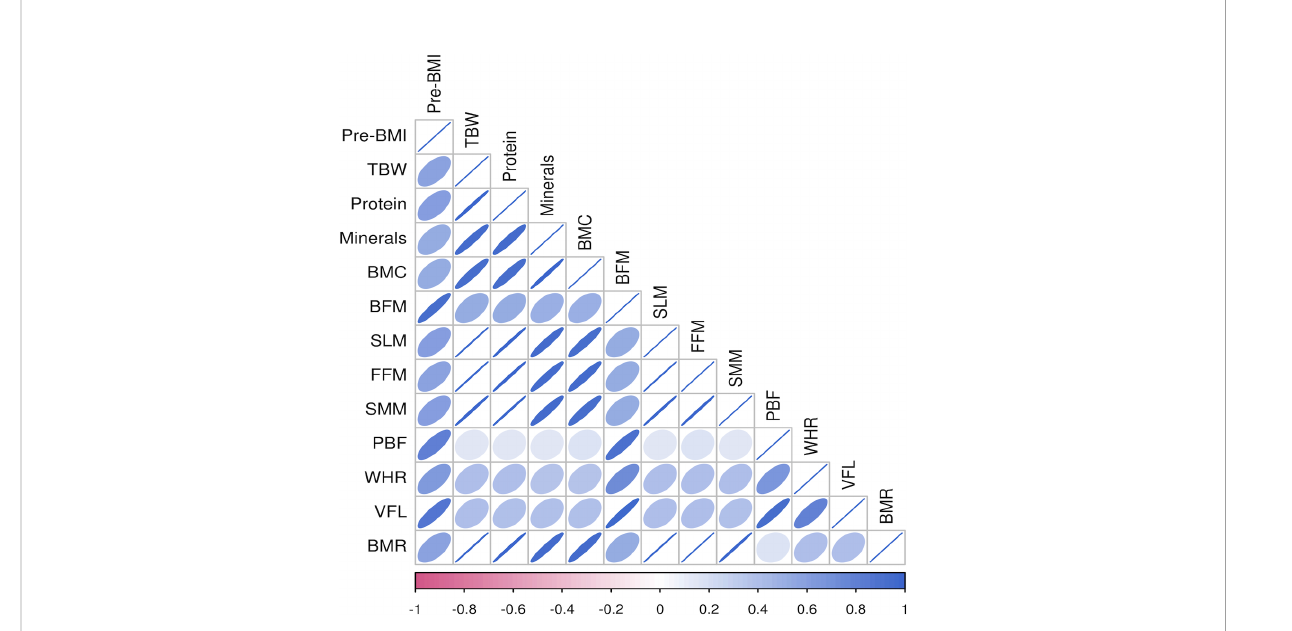
FIGURE 2 Heatmap of body composition correlations for pre-pregnancy BMI for all pregnant